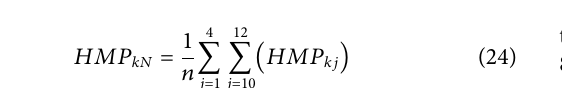
Frontiers in Physics |